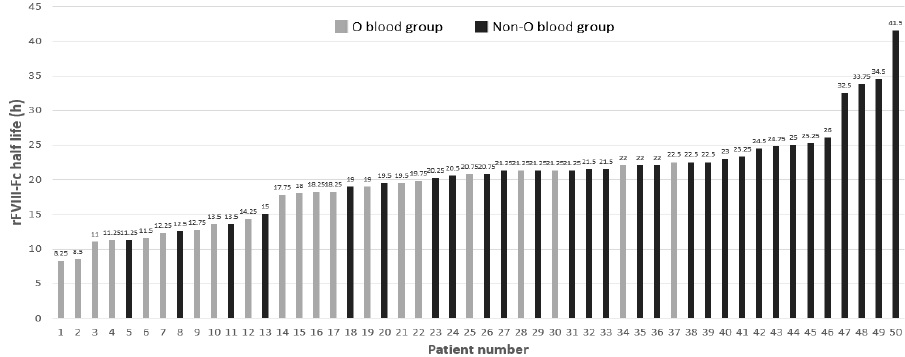
Figure 1. Distribution of rFVIII-Fc half lives marked by the O and non-O blood groups of the development cohort of the 50 people with hemophilia A (PwHA). The numbers above the bars denote the individual rFVIII-Fc half life (h). The gray-colored bars indicate PwHA with blood group O and appear more on the left side of the figure. The black-colored bars represent PwHA with blood group non-O and appear more on the right side.